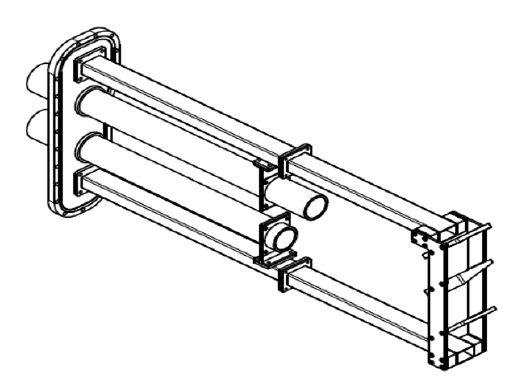
Figure 1. Two quasi-optical system for ECE front end